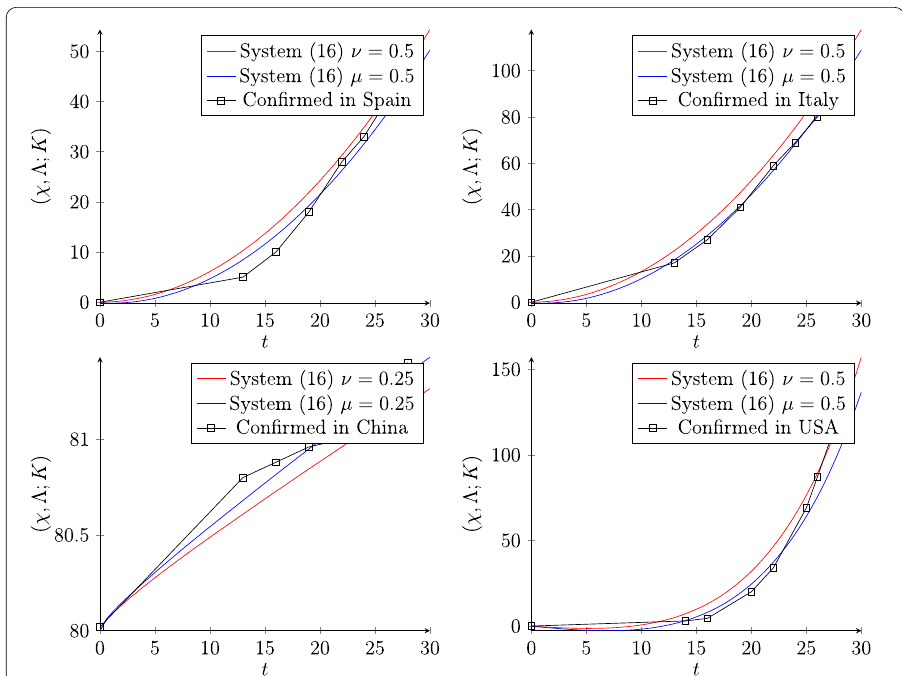
Figure 3 The dynamic process of system (16) with the connections σ ( t ) = 0.012 t and ρ ( t ) = 0.12( t + 1) for Spain data. Meanwhile for Italy data, which is rapidly increasing, we use σ ( t ) = 0.026 t and ρ ( t ) = 0.26( t + 1). China data in March have a stable distribution, therefore we suggest ν = μ = 0.25 with σ ( t ) = 80 + 0.033 t and ρ ( t ) = 0.34 t + 80. Finally, for the USA, the graph shows high conformation, thus we utilize exponential